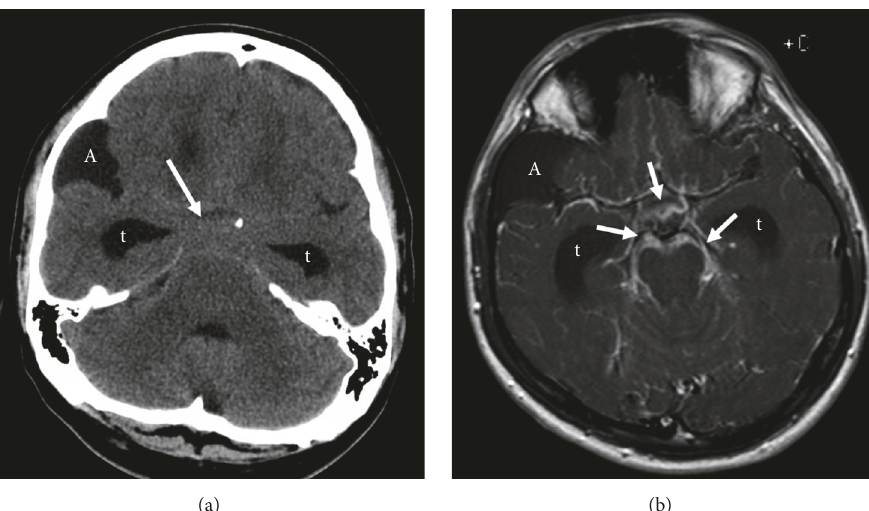
Figure 1: Axial noncontrastCT Head (a) and postcontrastT1 (b) MR images at the time of admission. Isodense basal leptomeningitis (arrow) on CT (a) with corresponding thick enhancement(arrows) on MRI (b). Hydrocephalus with dilated temporal horns (t). Incidental arachnoid cyst